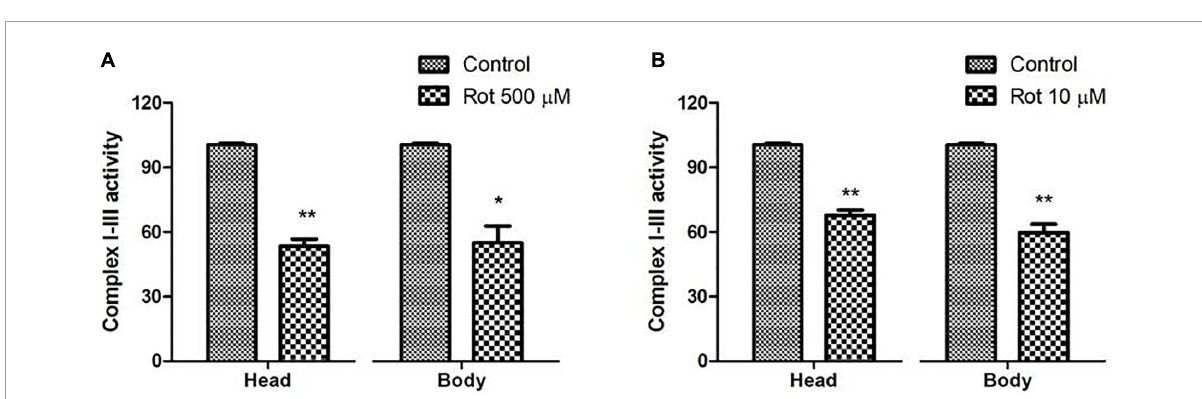
FIGURE3 Rotenone inhibits mitochondrial Complex I activity. Upon feeding the early health span fly with 500 µ M rotenone for 5 days (A) and 10 µ M ROT for 2 days during the transition phase (B) , there is a significant decrease of ∼ 45 and ∼ 35%, respectively, in the complex I–III activity of the respiratory chain in both the head and body parts of Drosophila melanogaster . Statistical analysis was performed using a t -test (compared to control). * p < 0.05, ** p <